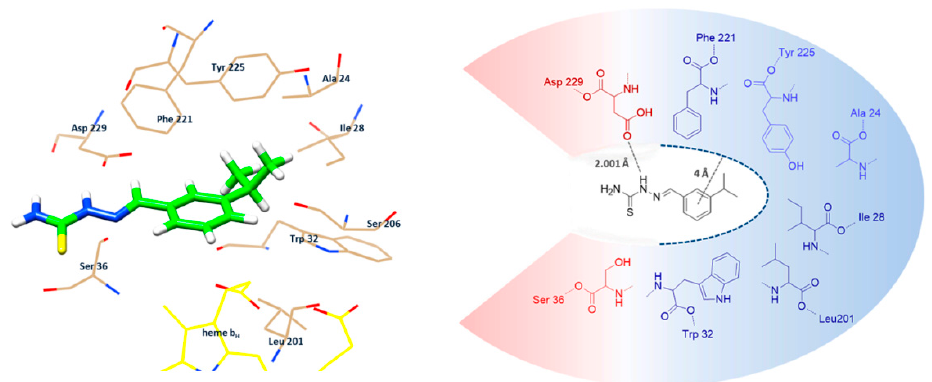
Figure 6. Representation of the binding mode of mHtcum in the cytochrome bc1 AMY binding site as obtained with the Gold v5.5 software. On the left: best docked pose of mHtcum into the 3BCC binding pocket. On the right: schematic positioning of mHtcum into the 3BCC binding pocket (in red: the hydrophilic area; in blue, the hydrophobic surface).